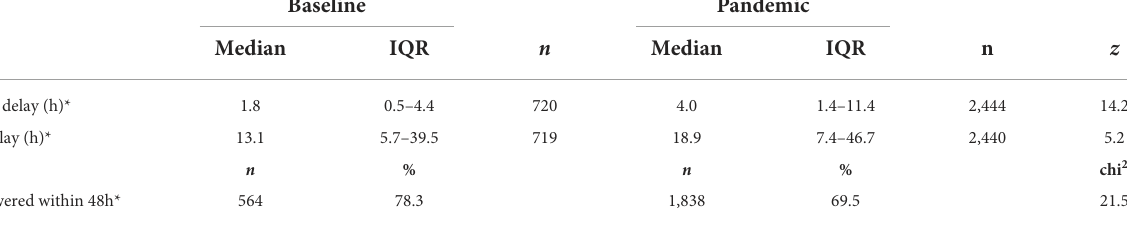
TABLE 2 Speed of response.